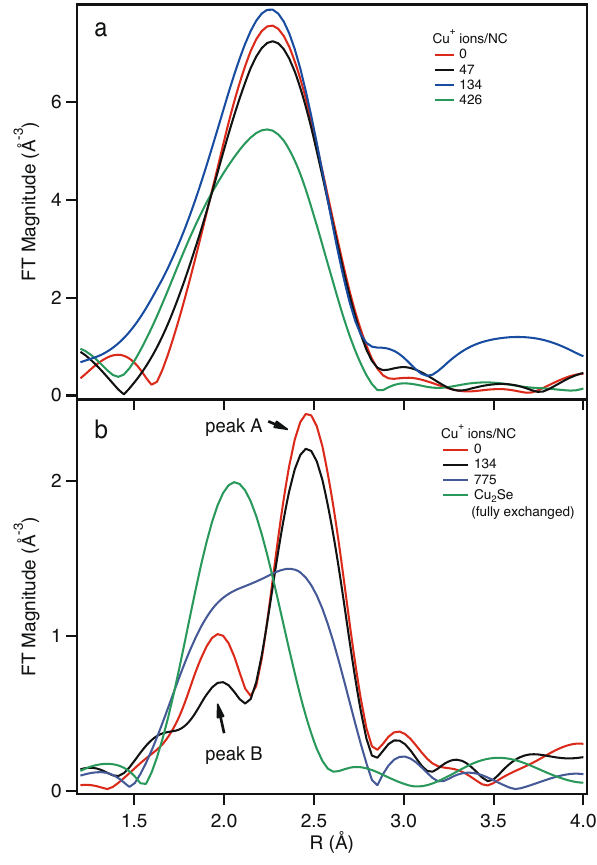
Fig. 3 Fourier transformed EXAFS data at the Cde and Se K-edges. Magnitude of the ( a ) Cd K-edge and ( b ) Se K-edge Fourier transformed EXAFS data for 5.0 nm CdSe NCs at various Cu